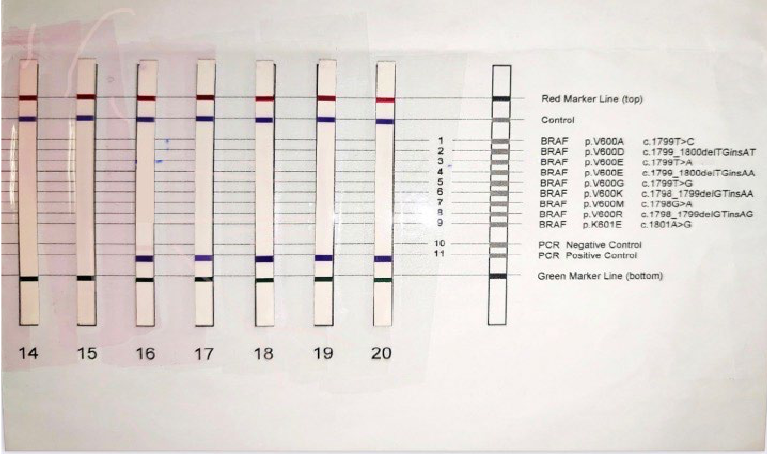
Figure 7. Negative BRAF gene mutation result. The genotyping was performed using the BRAF 600/601 StripAssay kit, which detects the mutations: V600E, V600A, V600D, V600E (c. 799T > A, c. 1799_1800TG > AA), V600G, V600K, V600M, V600R, K601E in the BRAF gene. The detection limit of the method is 1%.